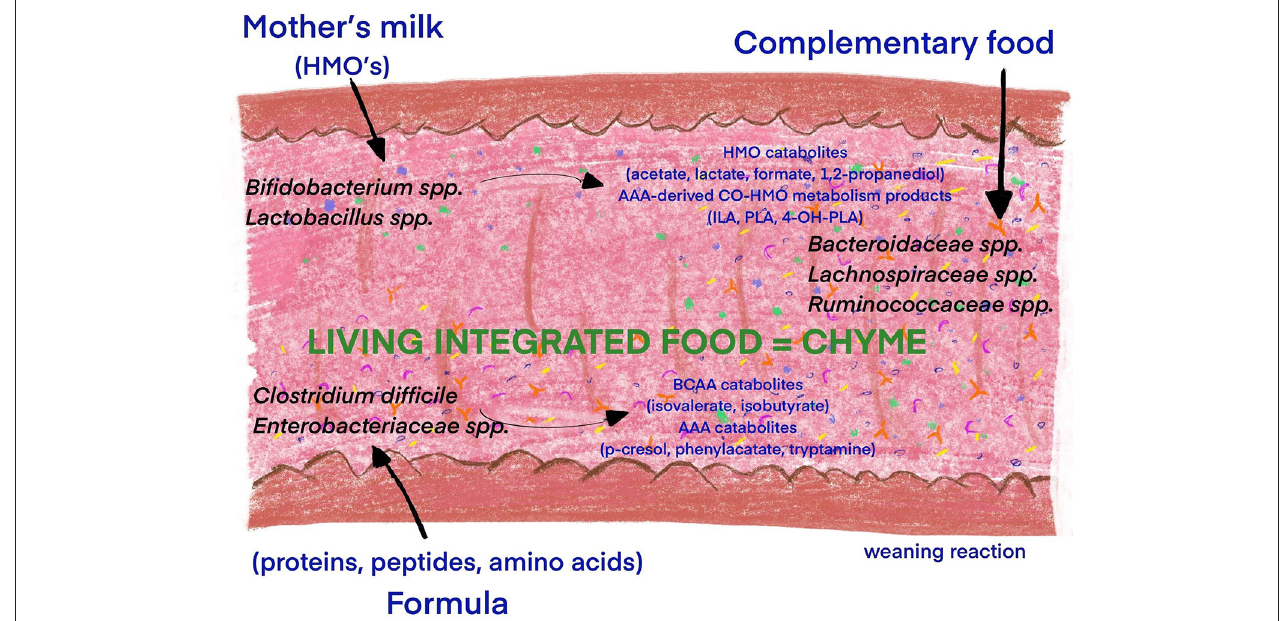
FIGURE 3 | Influence of diet introduction and food composition on the infant microbiota diversity. The introduction of feeding is a milestone in the development of adaptive immunity, the production of digestive enzymes and the transformation of the consumed milk into “living integrated food” (chyme). The diet is essential in the colonization processes during the early neonatal period, as well as in the establishment of a “lifelong” microbiota composition. The microbiome of breastfed infants consists predominantly of Bifidobacterium ( B. breve , B. longum , and B. bifidum ) and Lactobacillus (64). The utilization of HMOs from human milk by Bifidobacteria is especially beneficial for the production catabolites (Acetate Lactate Formate 1,2-Propanediol) and AAA-derived Co-HMO metabolism products (65). Formula-fed infants have a more diverse microbiota, with increased abundance of Bacteroidetes , Firmicutes , Clostridium difficile , and Enterobacteriaceae and in turn BCAA and AAA catabolites ( 64, 65). Complementary feeding increases gut microbial diversity with dominance of Lachnospiraceae , Ruminococcaceae , Bacteroidaceae , and Prevotellaceae species and production of BCFAs and SCFAs ( 65, 66). Human milk oligosaccharide (HMO), aromatic amino acid (AAA), branched chain amino acid (BCAA), indolelactate (ILA), phenyllactate (PLA), 4-hydroxypheyllactate (4-OH-PLA), branched chain fatty acids (BCFAs), and short-chain fatty acids